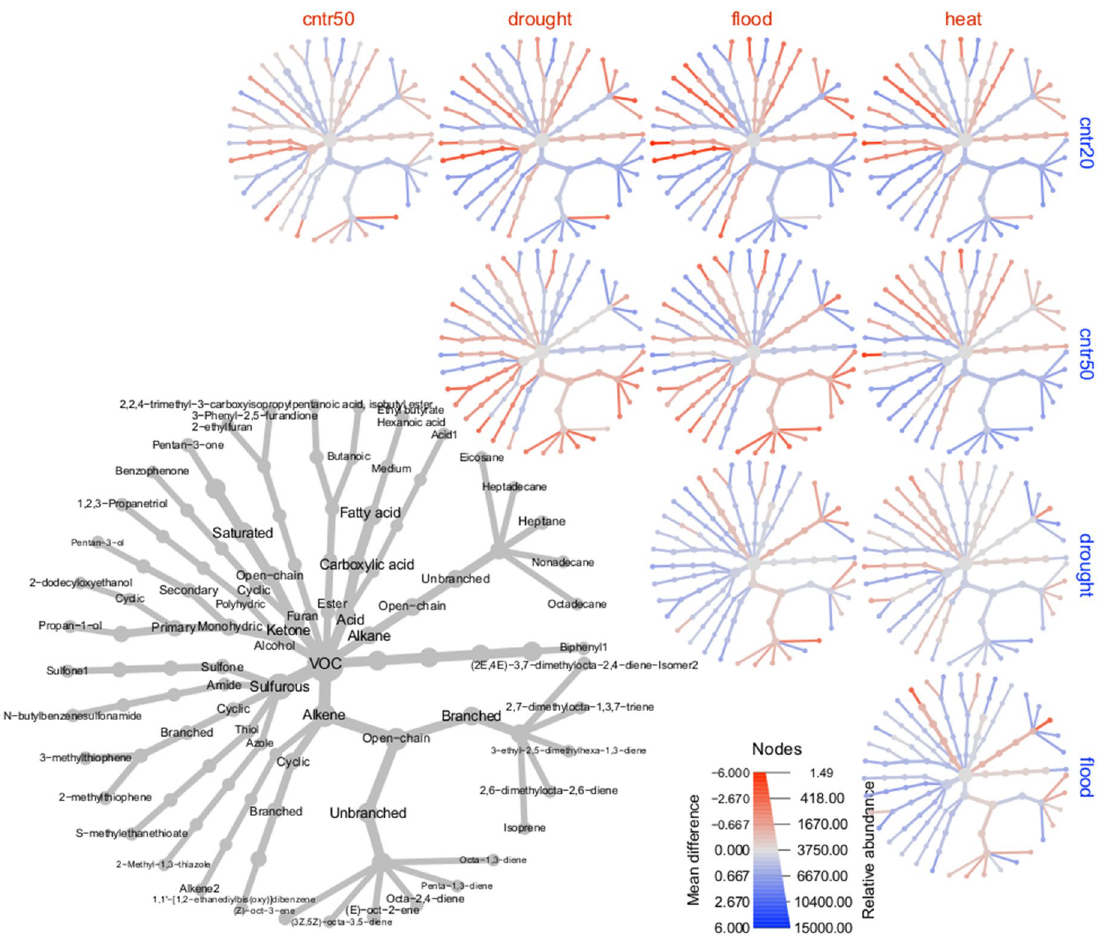
Figure 5. Comparisons between VOC profiles from grass varieties exposed to rumen fluid, broken down by climate scenario. Compounds are classified into hierarchical classes, and every node represents on the heat trees one compound or parent class. Node size is proportional to relative abundance for that class/compound. Each of the small heat trees represents a comparison between two climate scenarios. Node colour is on a scale representing the mean abundance change between conditions as a proportion of the total abundance of that compound: orange indicates that the compound had higher relative abundance in the ‘column’ treatment, grey indicates no difference, and blue indicates higher relative abundance in the ‘row’ treatment. Relative abundance is on an arbitrary scale where each sample sums to 100. For ease of viewing, compounds are only included if their relative abundance at least doubled in at least one comparison. For this reason, in some cases a node will show a different direction of change to its parent nodes (i.e. other compounds, not included in the plot, contribute to the parent node’s direction of